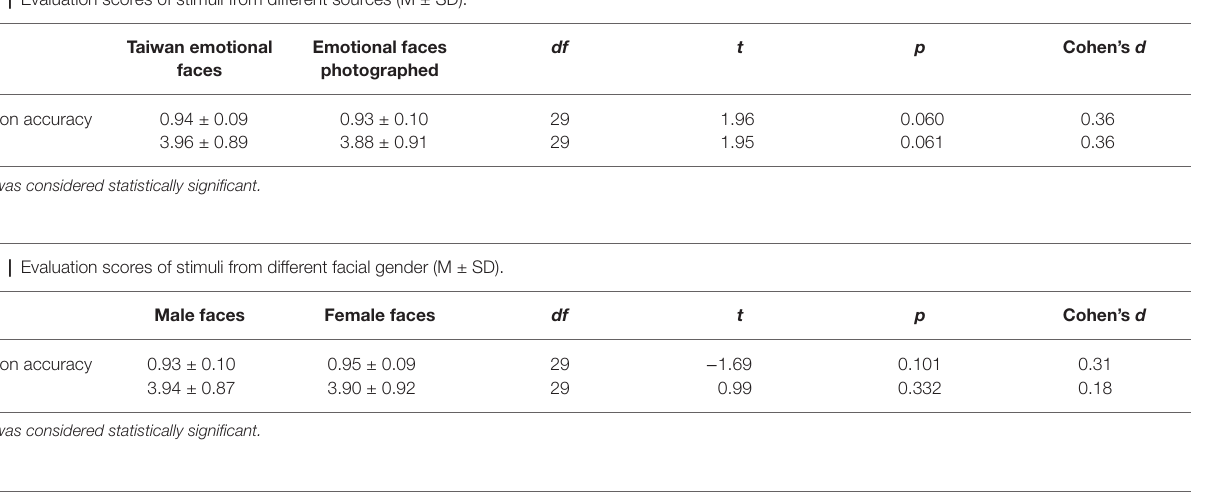
TABLE 1 | Evaluation scores of stimuli from different sources (M ± SD).